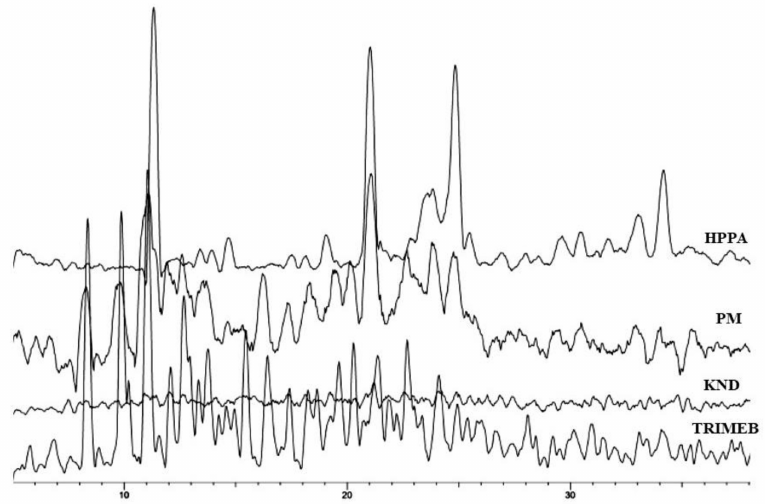
Figure 3. The XRD patterns of HPPA, TRIMEB, KND, and